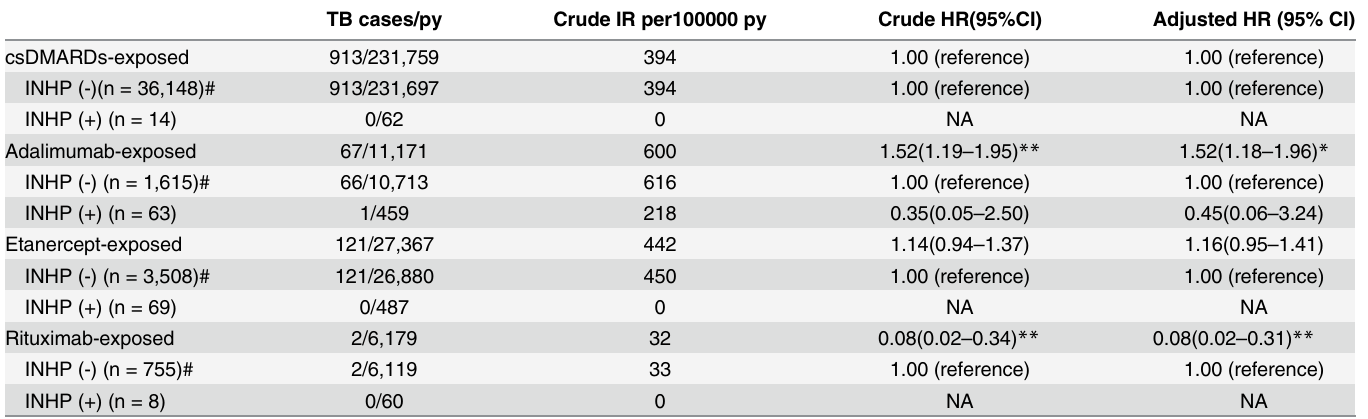
Table 3. Incidence rates (IRs) and hazard ratios (HRs) of tuberculosis (TB) disease by biologic exposure with csDMARDs-exposed patients as ref- erence group, and by isoniazid prophylaxis therapy (INHP) with the absence of INHP as reference